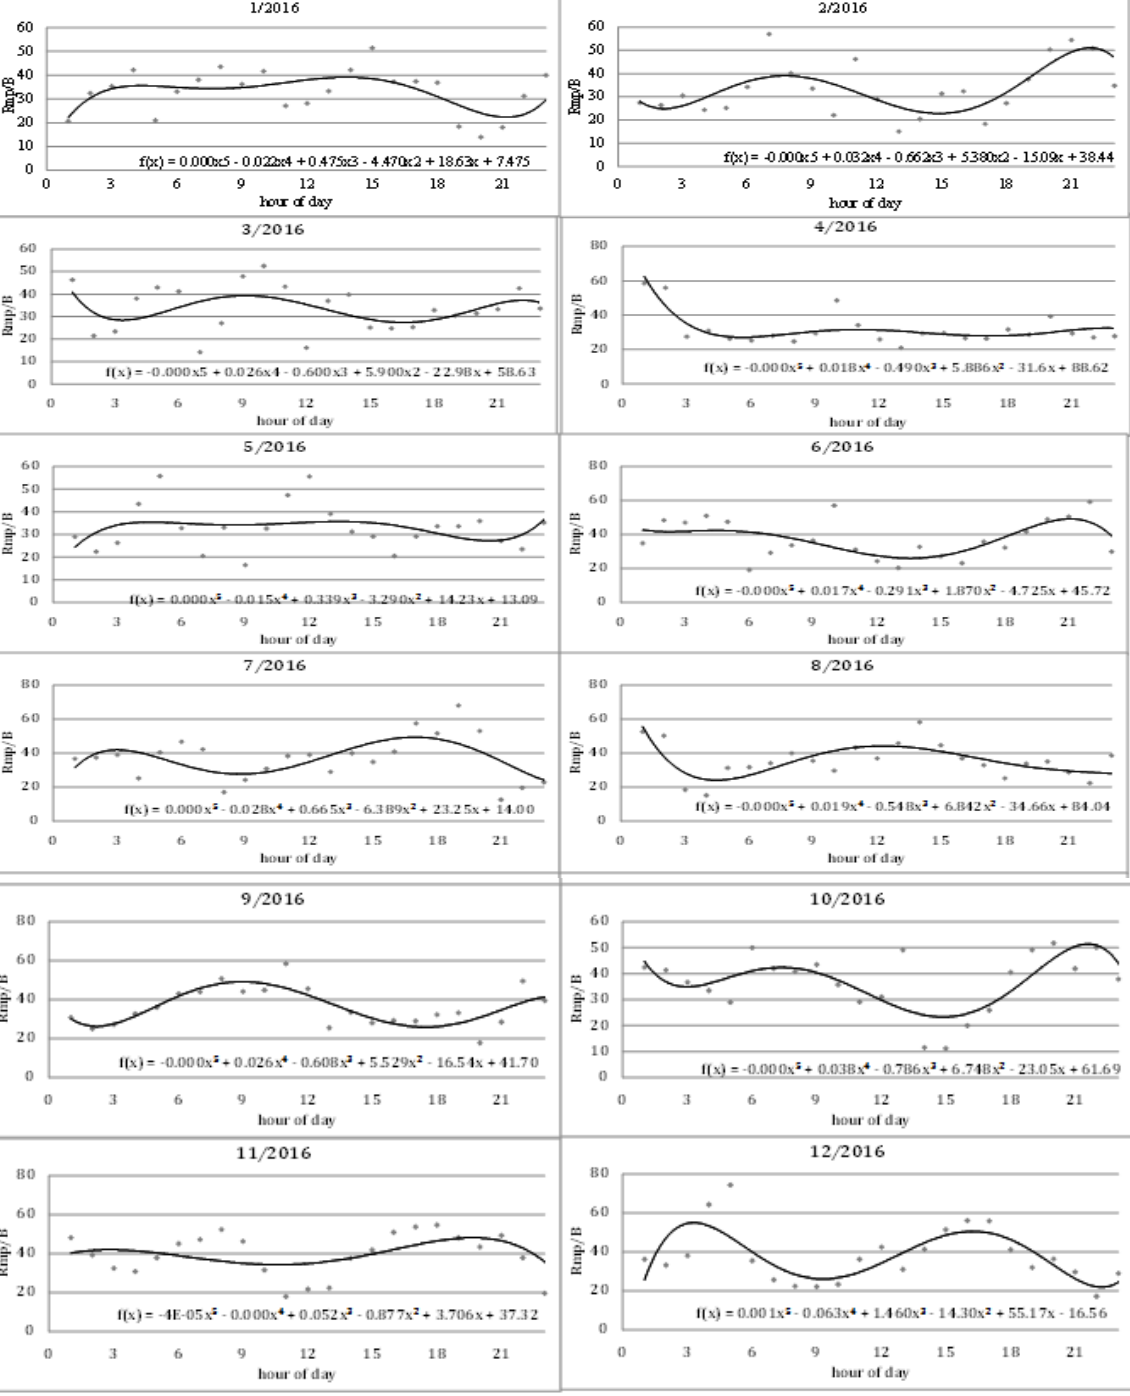
/B ) for year mp o